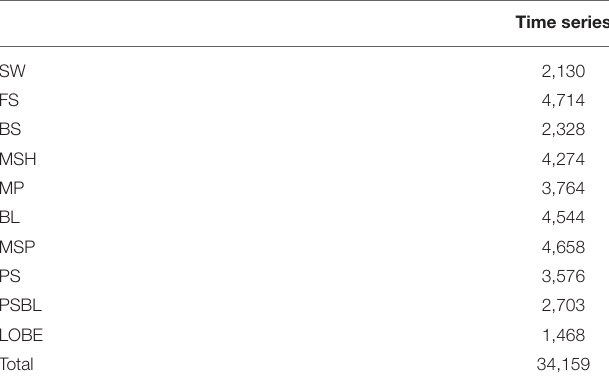
TABLE 2 | Number of occurrences for each